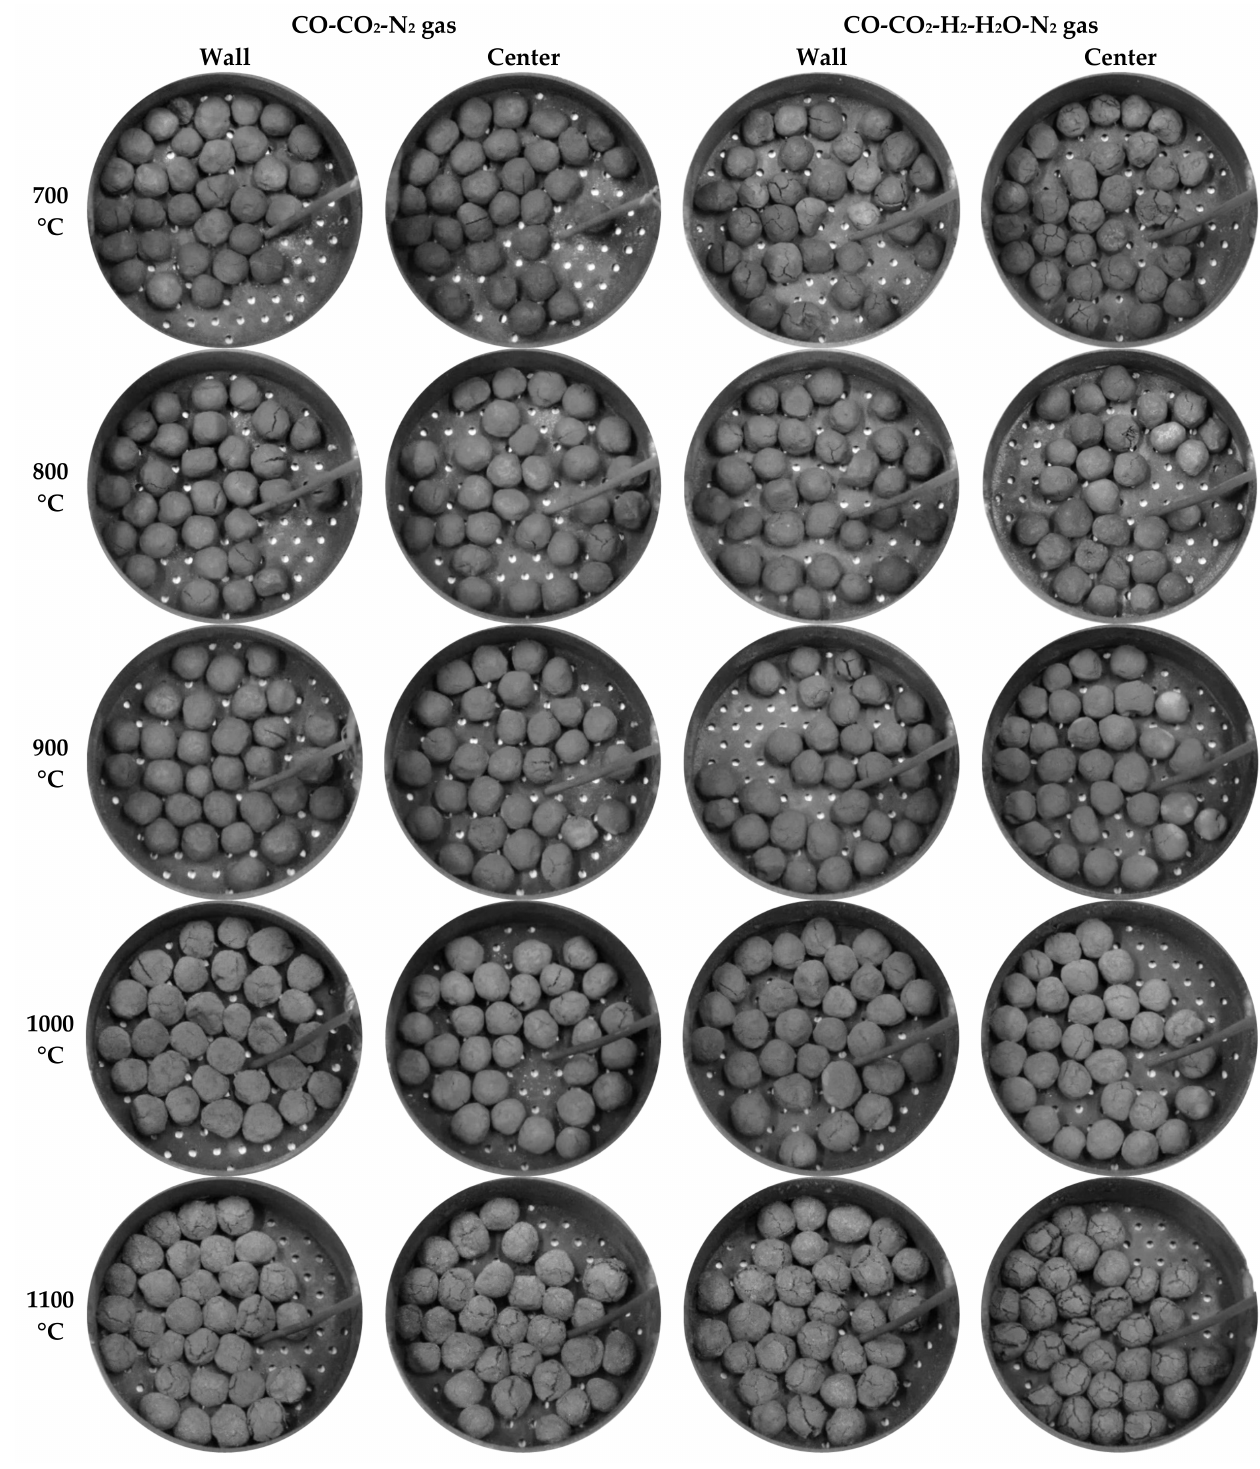
Figure 5. Pellets photographed in the sample basket after isothermal reduction, using the wall and center profiles in CO-CO 2 -N 2 and CO-CO 2 -H 2 -H 2 O-N 2